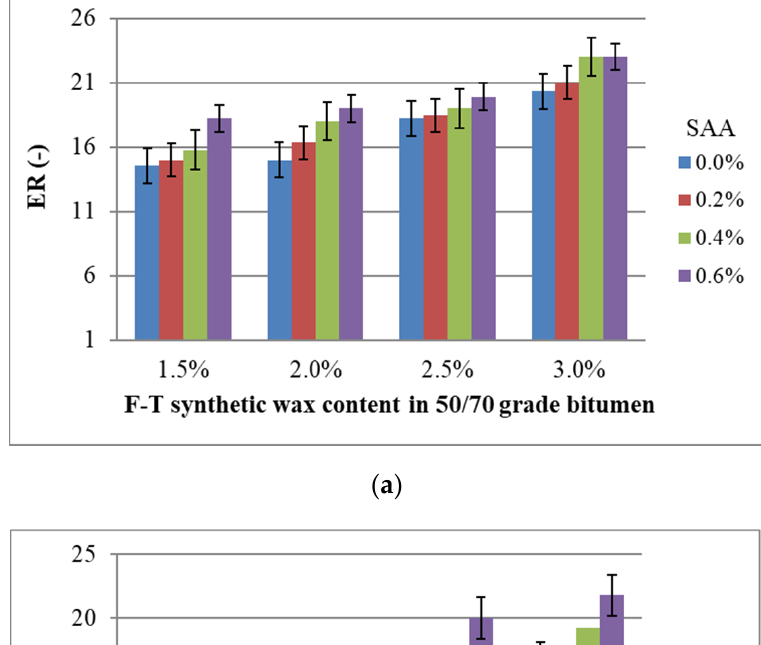
( d ) ( e ) Figure 20. Bitumen 50/70 foam characteristics ( a ), bitumen 50/70 + 0.6% SAA + 1.5% F–T ( b ), bitumen 50/70 + 0.6% SAA+ The results of testing the foam characteristics of bitumen 50/70 while ensuring the optimum amount of foaming water with respect to the addition of chemical additives used are shown in Figure 21.